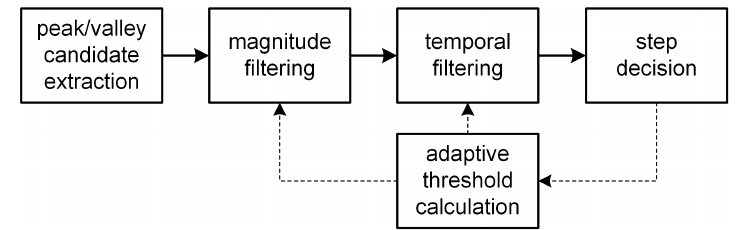
Figure 2. Proposed step detection